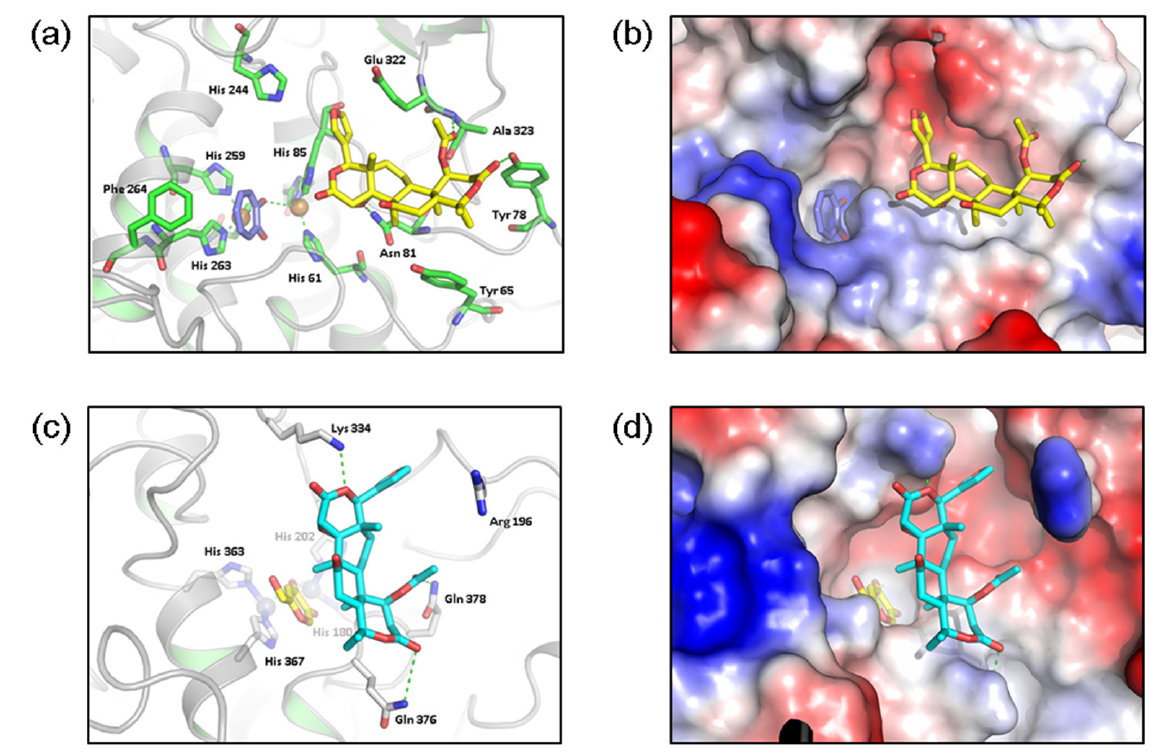
Figure 5. Molecular docking study. ( a ) Binding model of mushroom tyrosinase and nomilin; ( b ) surface model of mushroom tyrosinase and nomilin; ( c ) binding model of human tyrosinase and nomilin; ( d ) surface model of human tyrosinase and nomilin.